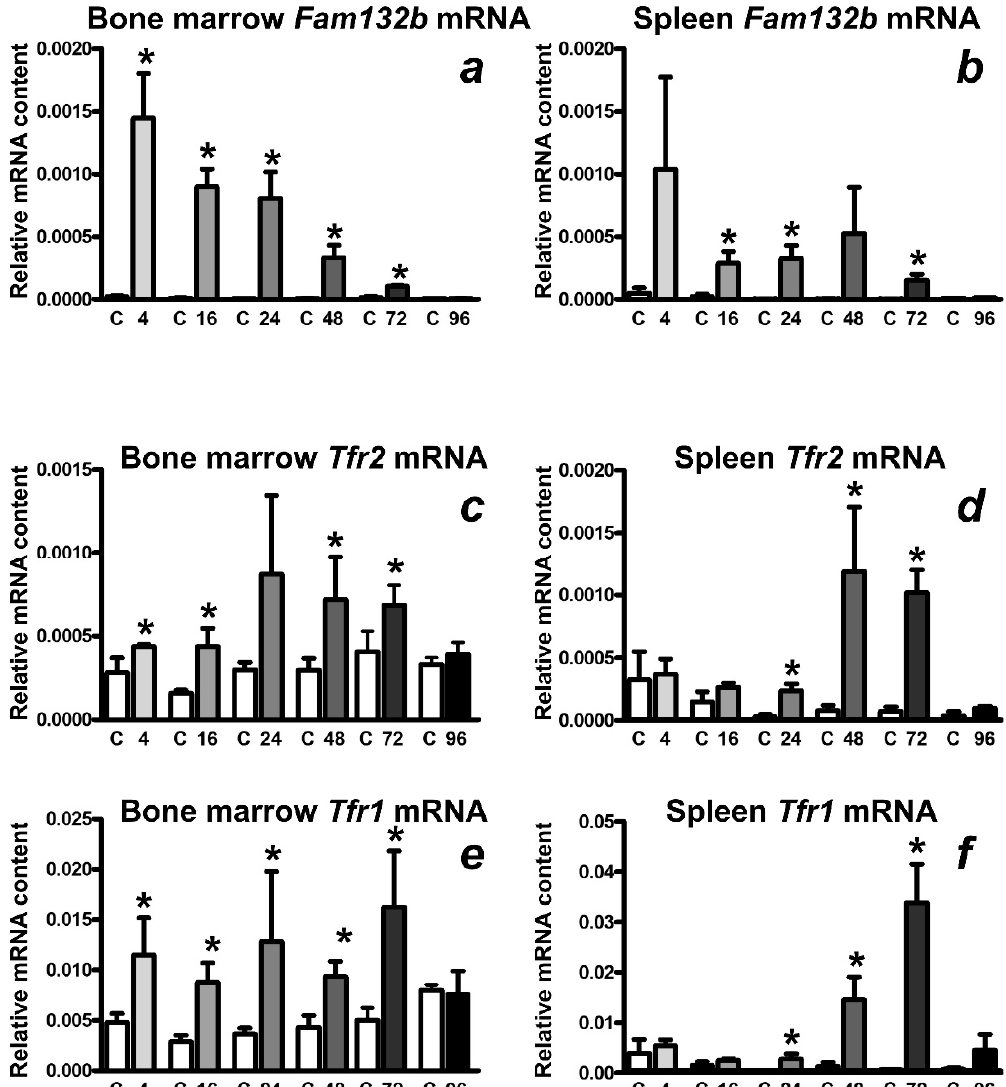
Figure 2. ( a , b ) Single injection of EPO rapidly upregulates Fam132b mRNA in the bone marrow and spleen. ( c , d ) Single injection of EPO upregulates splenic Tfr2 mRNA at 48 h and 72 h after injection. ( e , f ) Single injection of EPO upregulates splenic Tfr1 mRNA at 48 h and 72 h after injection. EPO was administered at 200 U/mouse, mRNA content was determined at the indicated time points in groups of three control mice (C) and three EPO-treated mice. Target mRNA content is expressed relative to Actb expression, * denotes statistical significance between EPO-treated group and the respective control group ( p < 0.05). Values were obtained from two independent experiments.